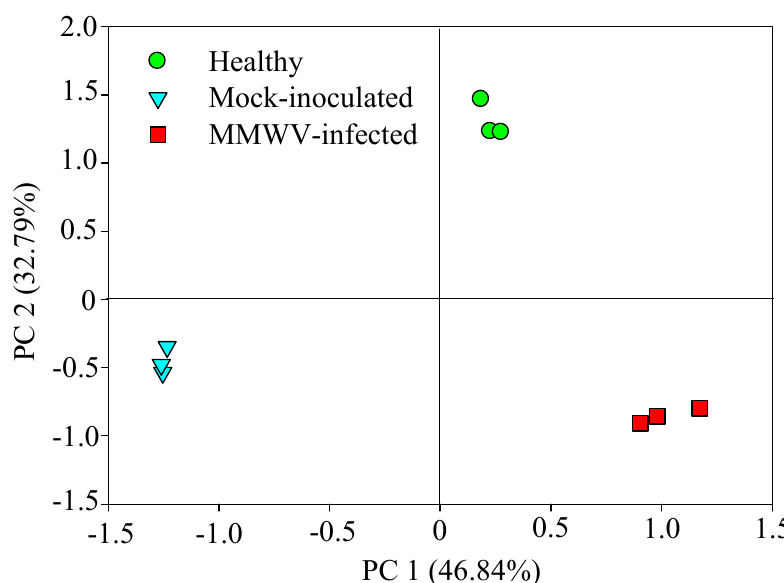
Figure 5. Principal component analysis (PCA) of VOCs released from healthy, MMWV-infected and mock-inoculated plants.